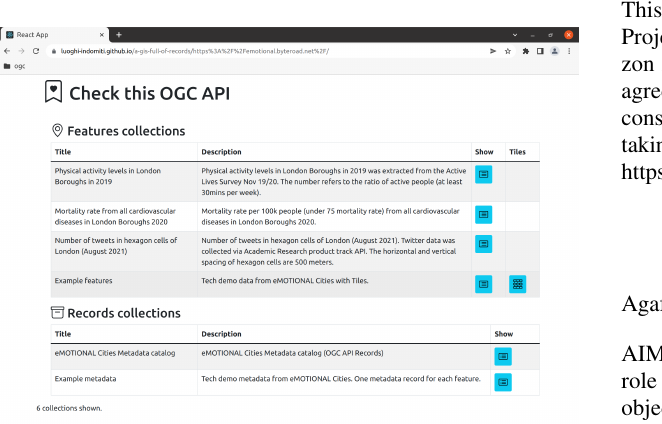
Figure 8. A crawlable catalogue in Stac Browser